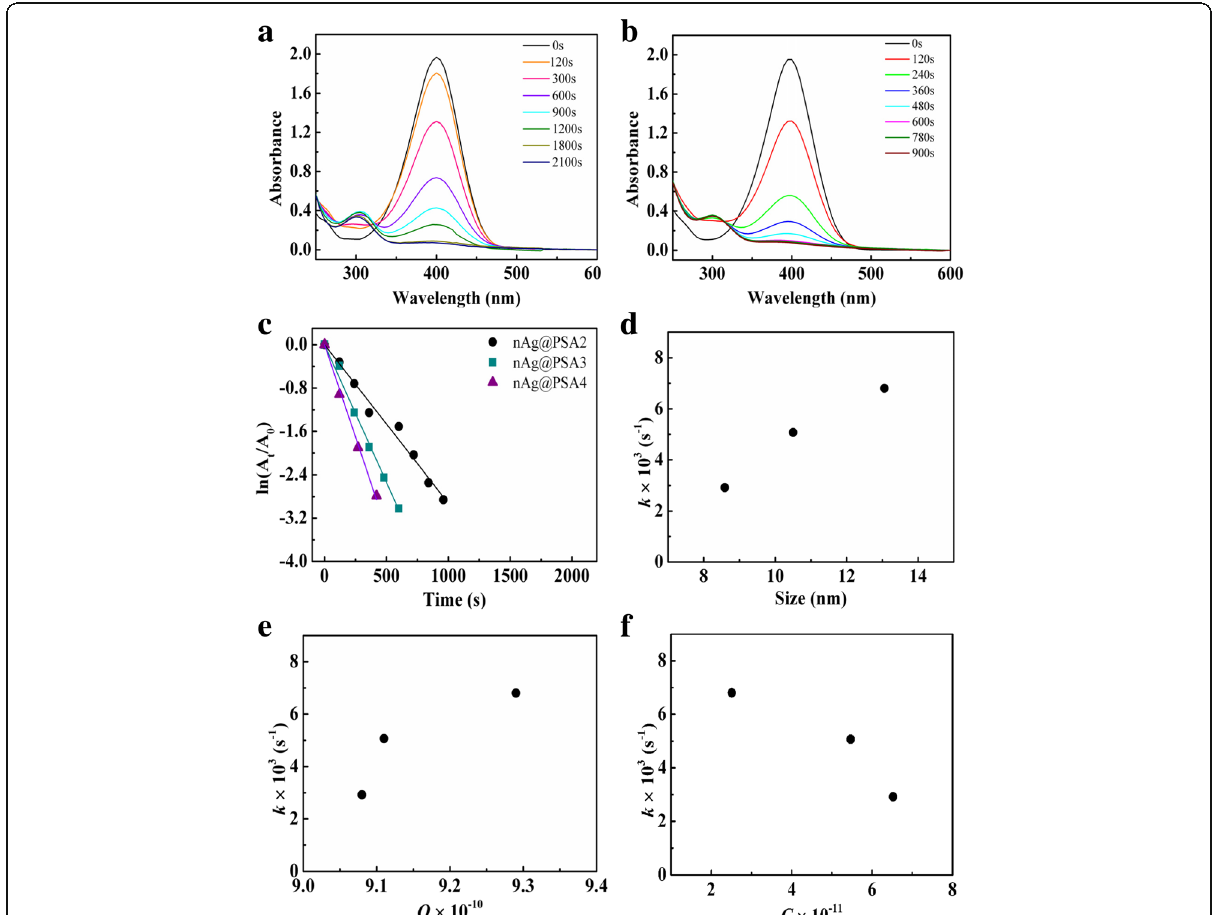
Fig. 10 a UV-vis spectra of 0.12 mM 4-NP with 36 mM NaBH 4 in the presence of nAg@PSA2 nanocomposites (containing 0.0068 mg Ag). b UV-vis spectra of 0.12 mM 4-NP with 36 mM NaBH 4 in the presence of nAg@PSA3 nanocomposites (containing 0.0068 mg Ag). c Plot of ln(A t /A 0 ) against the reaction time in the presence of nAg@PSA nanocomposites (containing 0.0068 mg Ag) obtained from PSA2 – PSA4 nanospheres. d Effects of the particle size of silver nanoparticles on the rate constant. e Effects of the silver amount per square centimeter of PSA nanospheres surface on the rate constant. f Effects of the nanosphere amount per cubic centimeter of nAg@PSA suspension on the rate